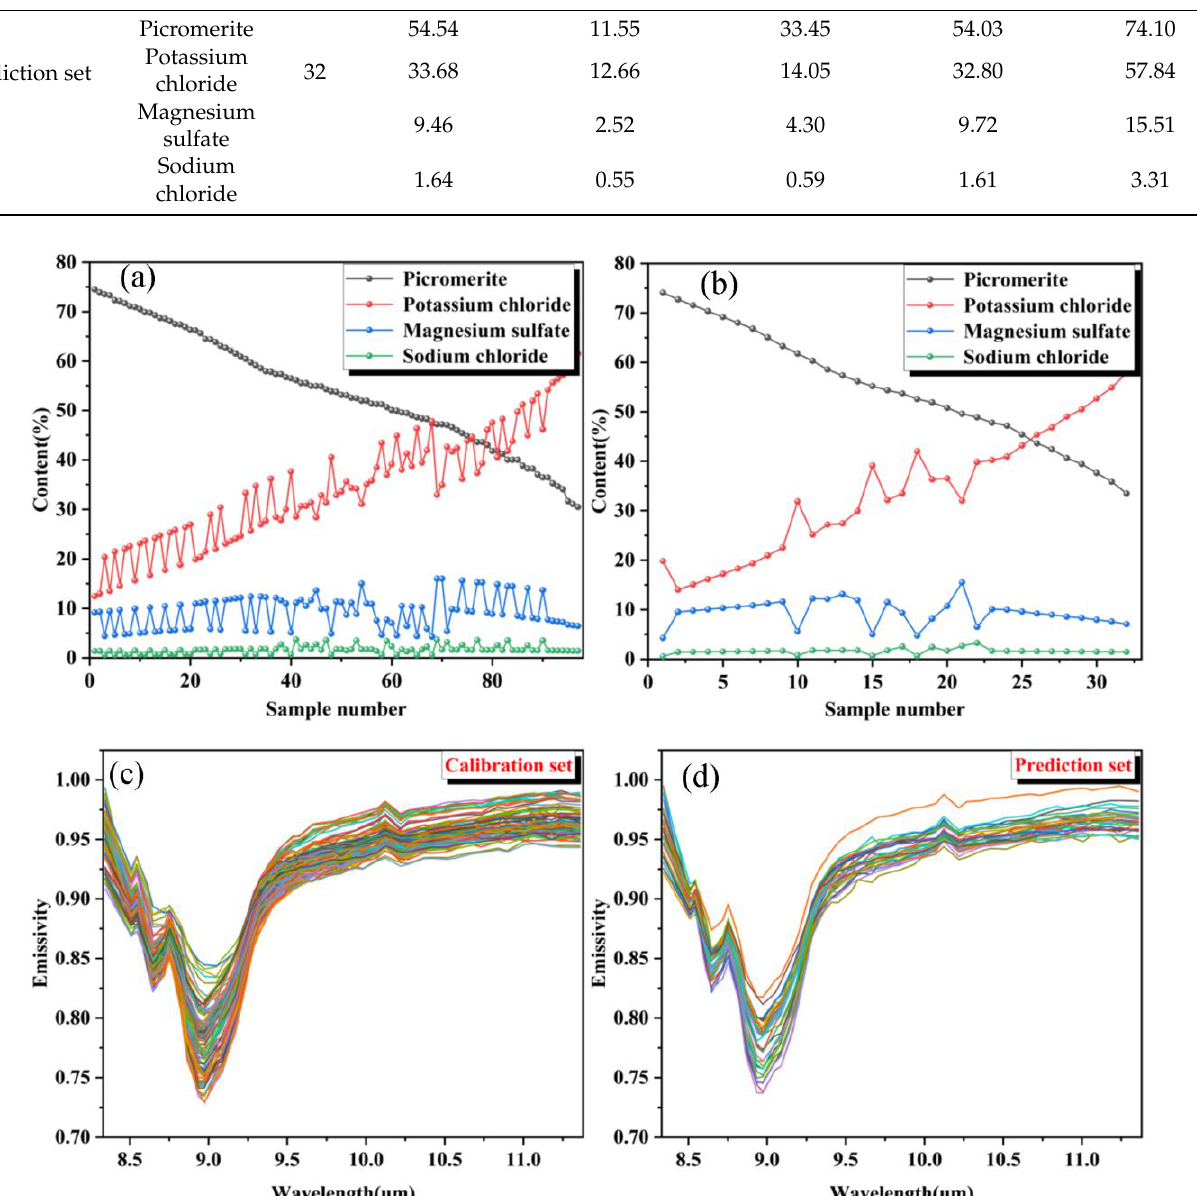
Table 4. Mineral composition statistics from the calibration set (104 MP samples) and the prediction set (34 MP samples): mean, standard deviation, minimum, median, and maximum.